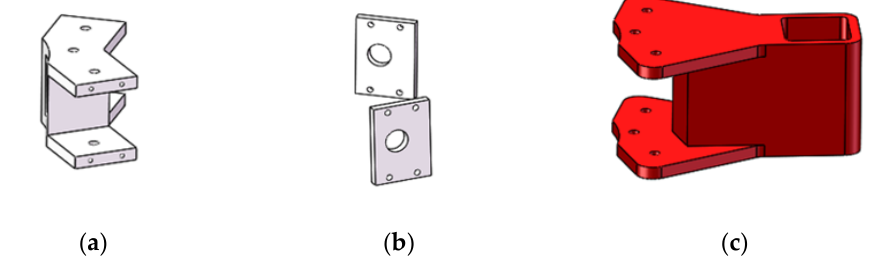
Figure 5. Holder. ( a ) Finger connector; ( b ) plate; ( c ) holder main body.